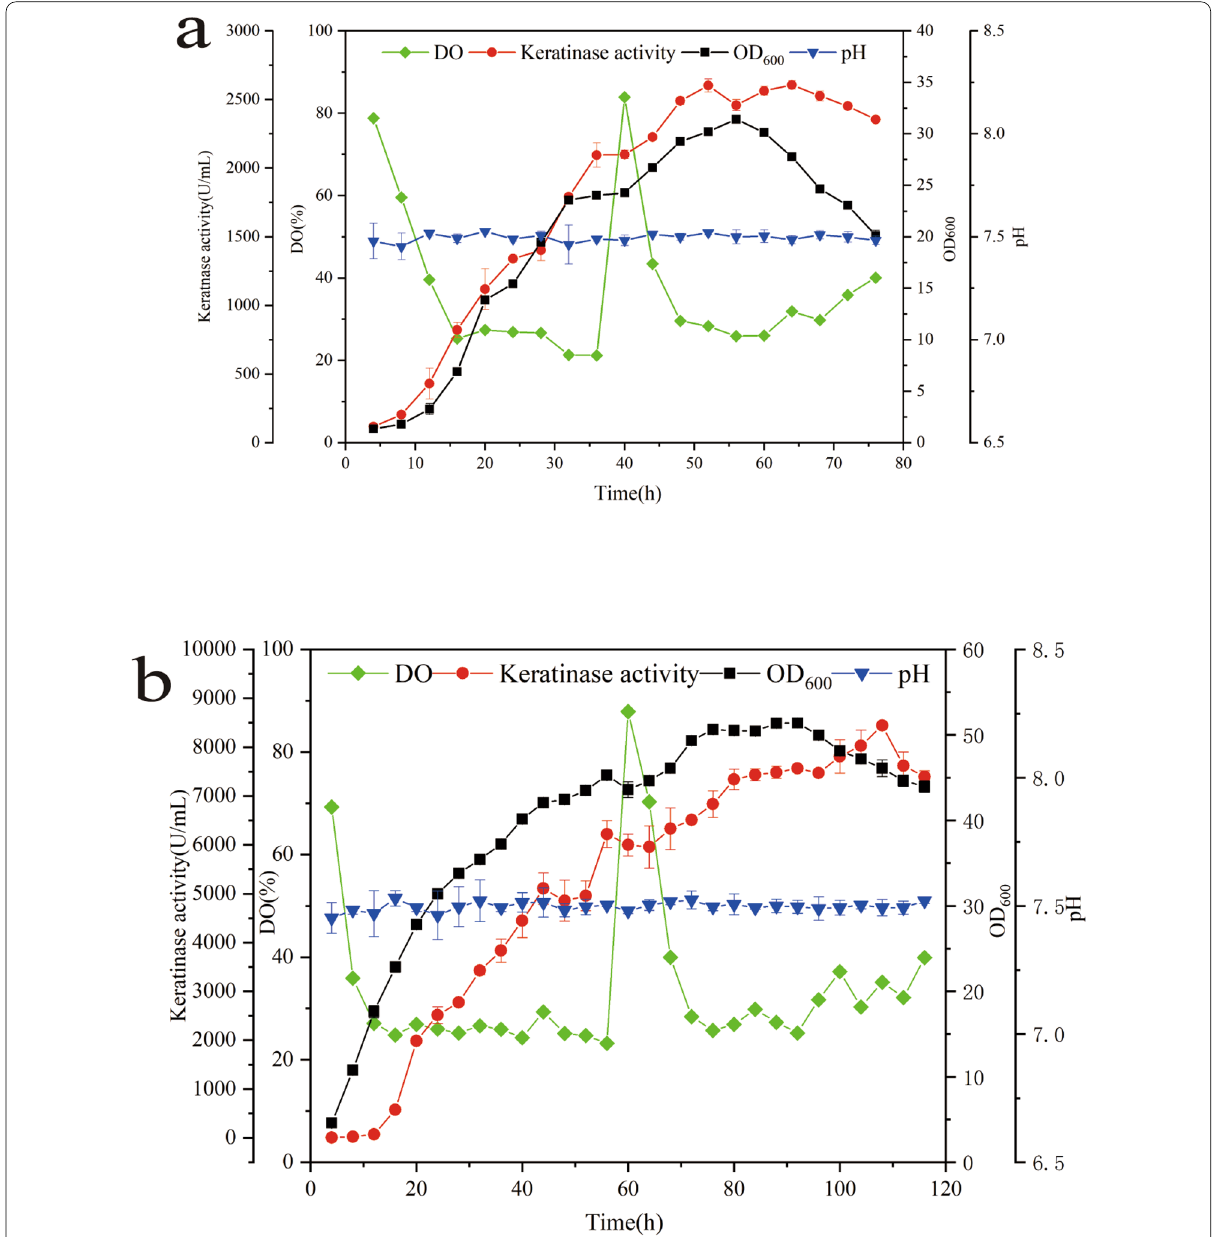
Fig. 4 High‑density fermentation of the variant T18 and the original strain in a 7‑L fermenter. a WT; b variant